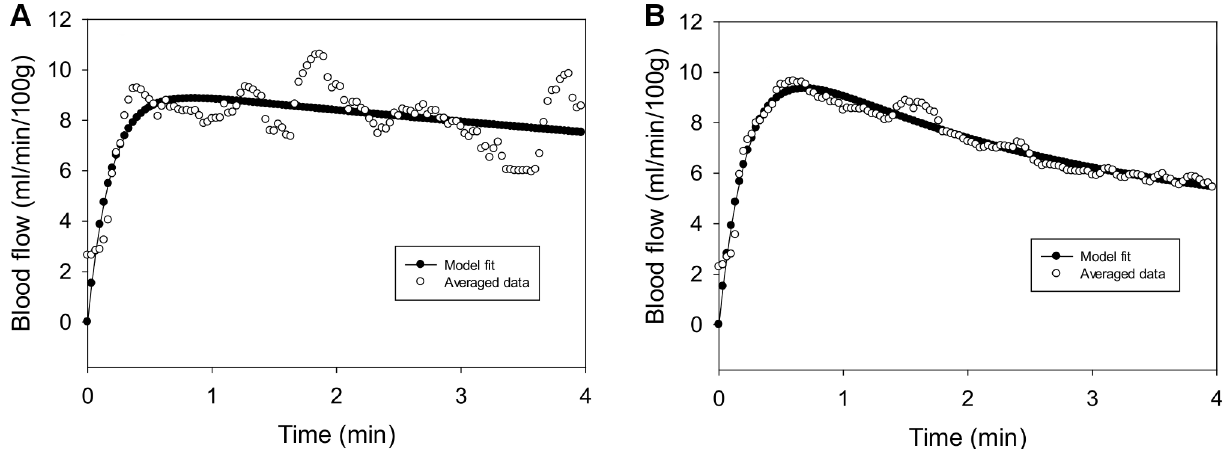
Figure 5. Fitted results for average reactive hyperemia. The explicit expression of I 2 ( t ) was used for finding best-fit results. Calibration was performed using Matlab R2011. Panel (A) shows the best-fit result in people with SCI. Panel (B) shows the best-fit result in people without SCI.